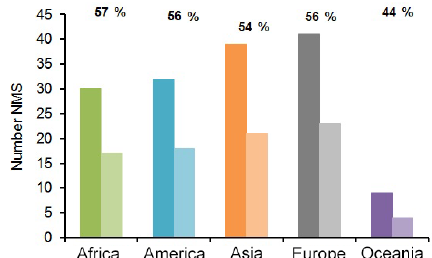
Figure 2. Yearly distribution of NMSs incorporation on Facebook (May